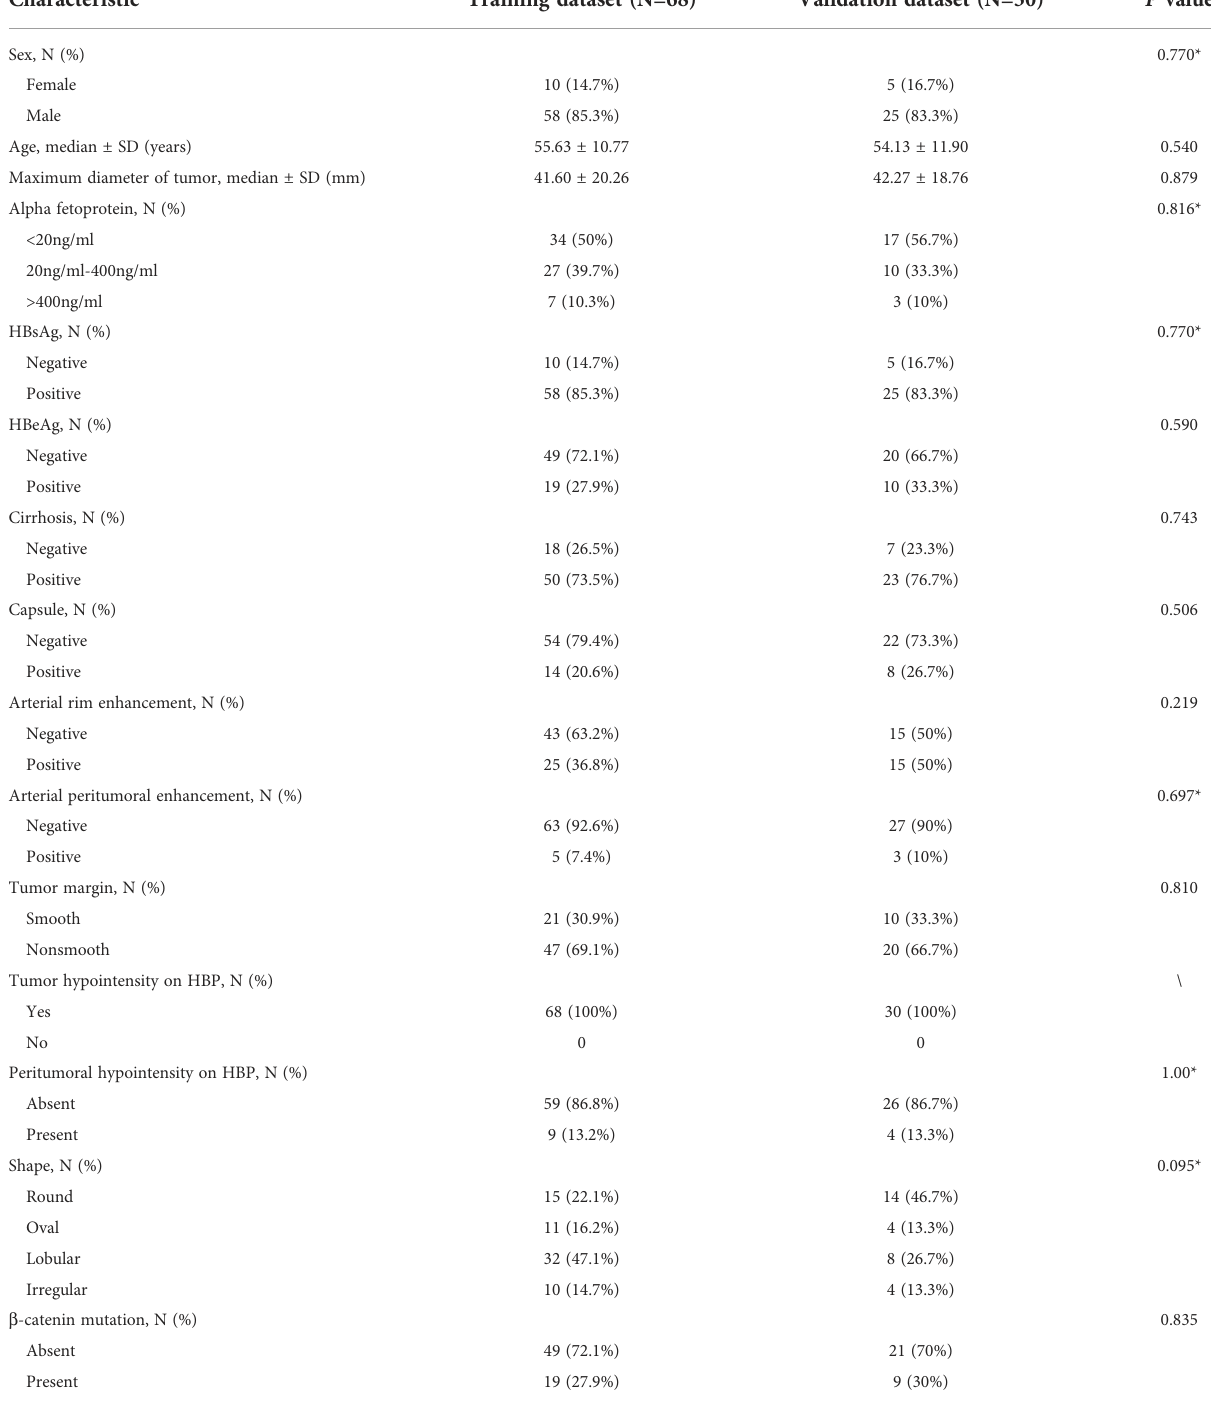
TABLE 2 Baseline clinical characteristics of the training and validation